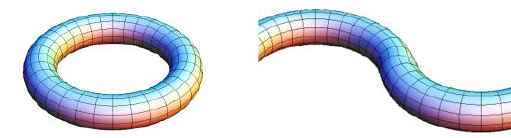
Figure 1. Representation of a torus and the juxtaposition of two torus